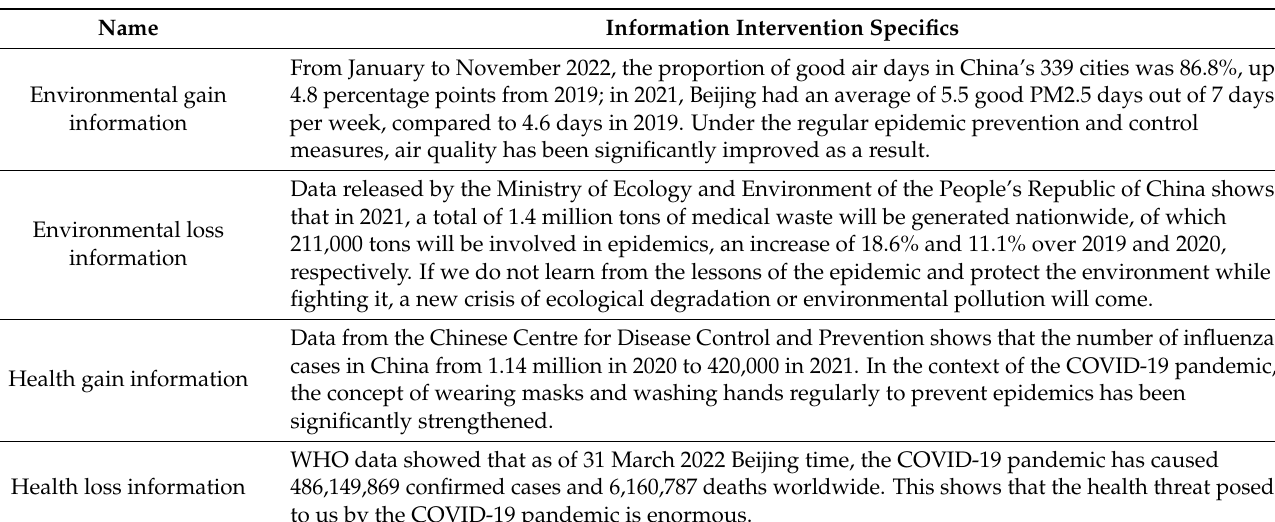
Figure 1. Experimental design diagram. Table 2. The contents of the four information intervention strategies.